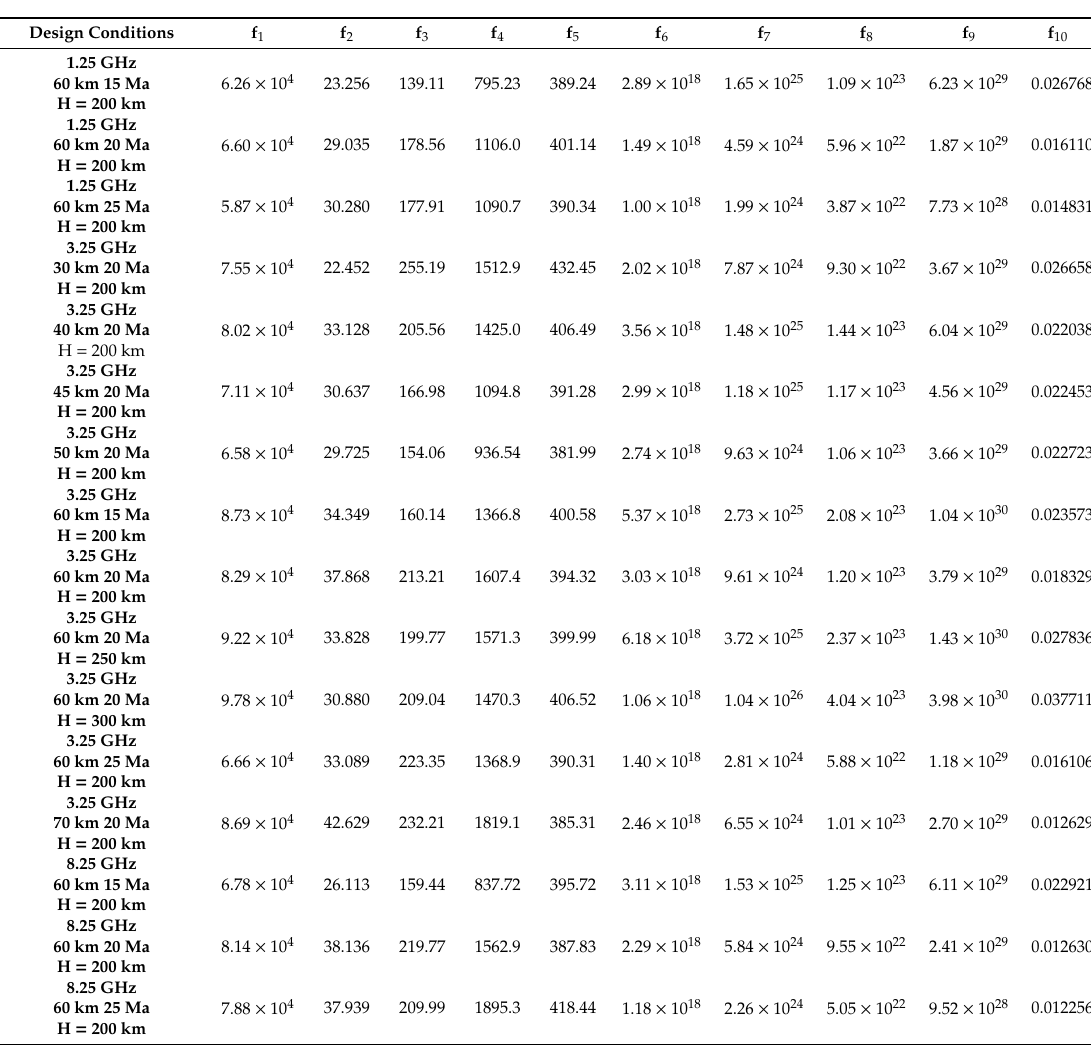
Table 2. Ten e ff ective statistical characteristic values extracted on the time-scale plane after continuous wavelet transform for the dynamic RCS of a hypersonic vehicle under di ff erent calculation conditions.